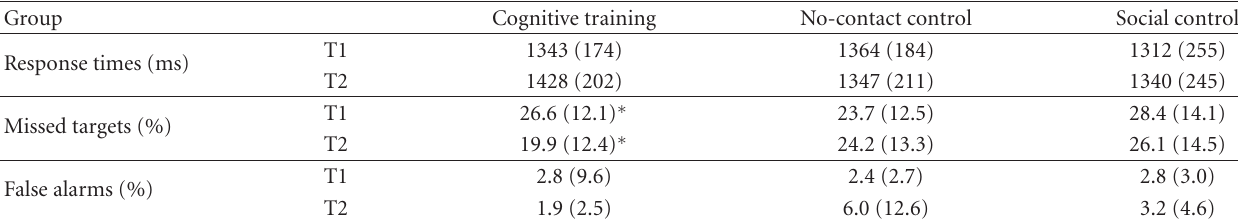
Table 2: Performance data of the participant groups separately for the test sessions before (T1) and after (T2) the four-month training interval. Standard deviations are given in parentheses behind the mean values. Significant performance changes within the groups from the first to the second test session are indicated by asterisks ( P < .